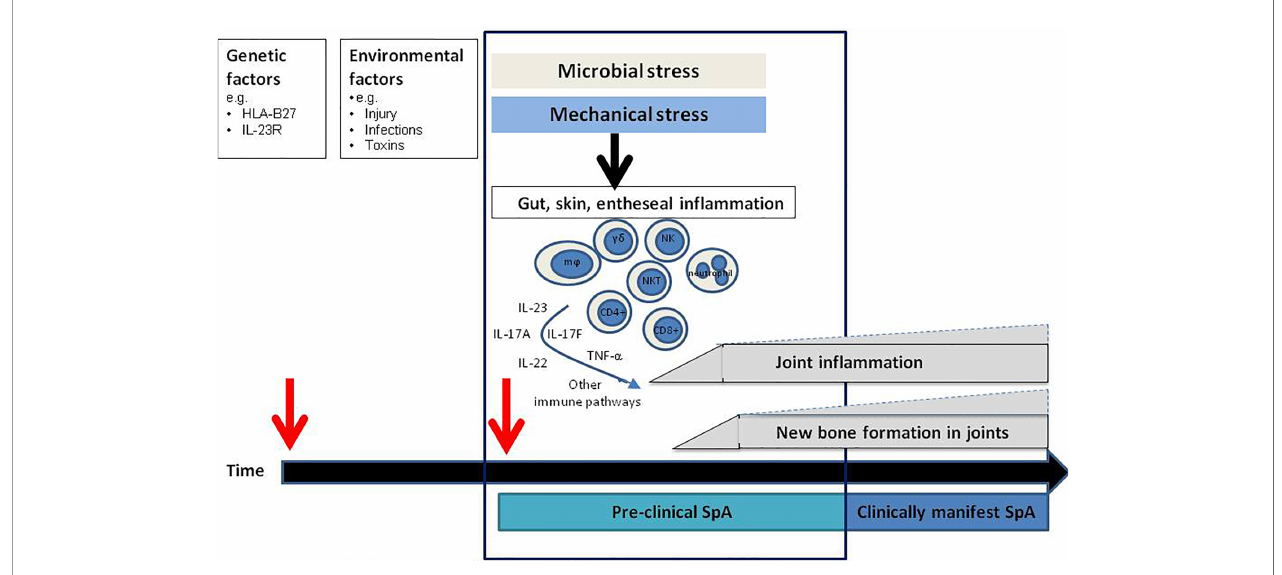
FIGURE 1 | Hypothetical model for the disease initiation phase: the pre-clinical phase. In the pre-clinical phase of disease innate immune triggering results in activation of speci fi c pathogenic immune pathways site distant from the joints resulting in (subclinical) joint in fl ammation and new bone formation which subsequently develops into clinically manifest spondyloarthritis (SpA). m f , macrophages, NK, NK cells; NKT, NKT cells; gd , gamma delta T